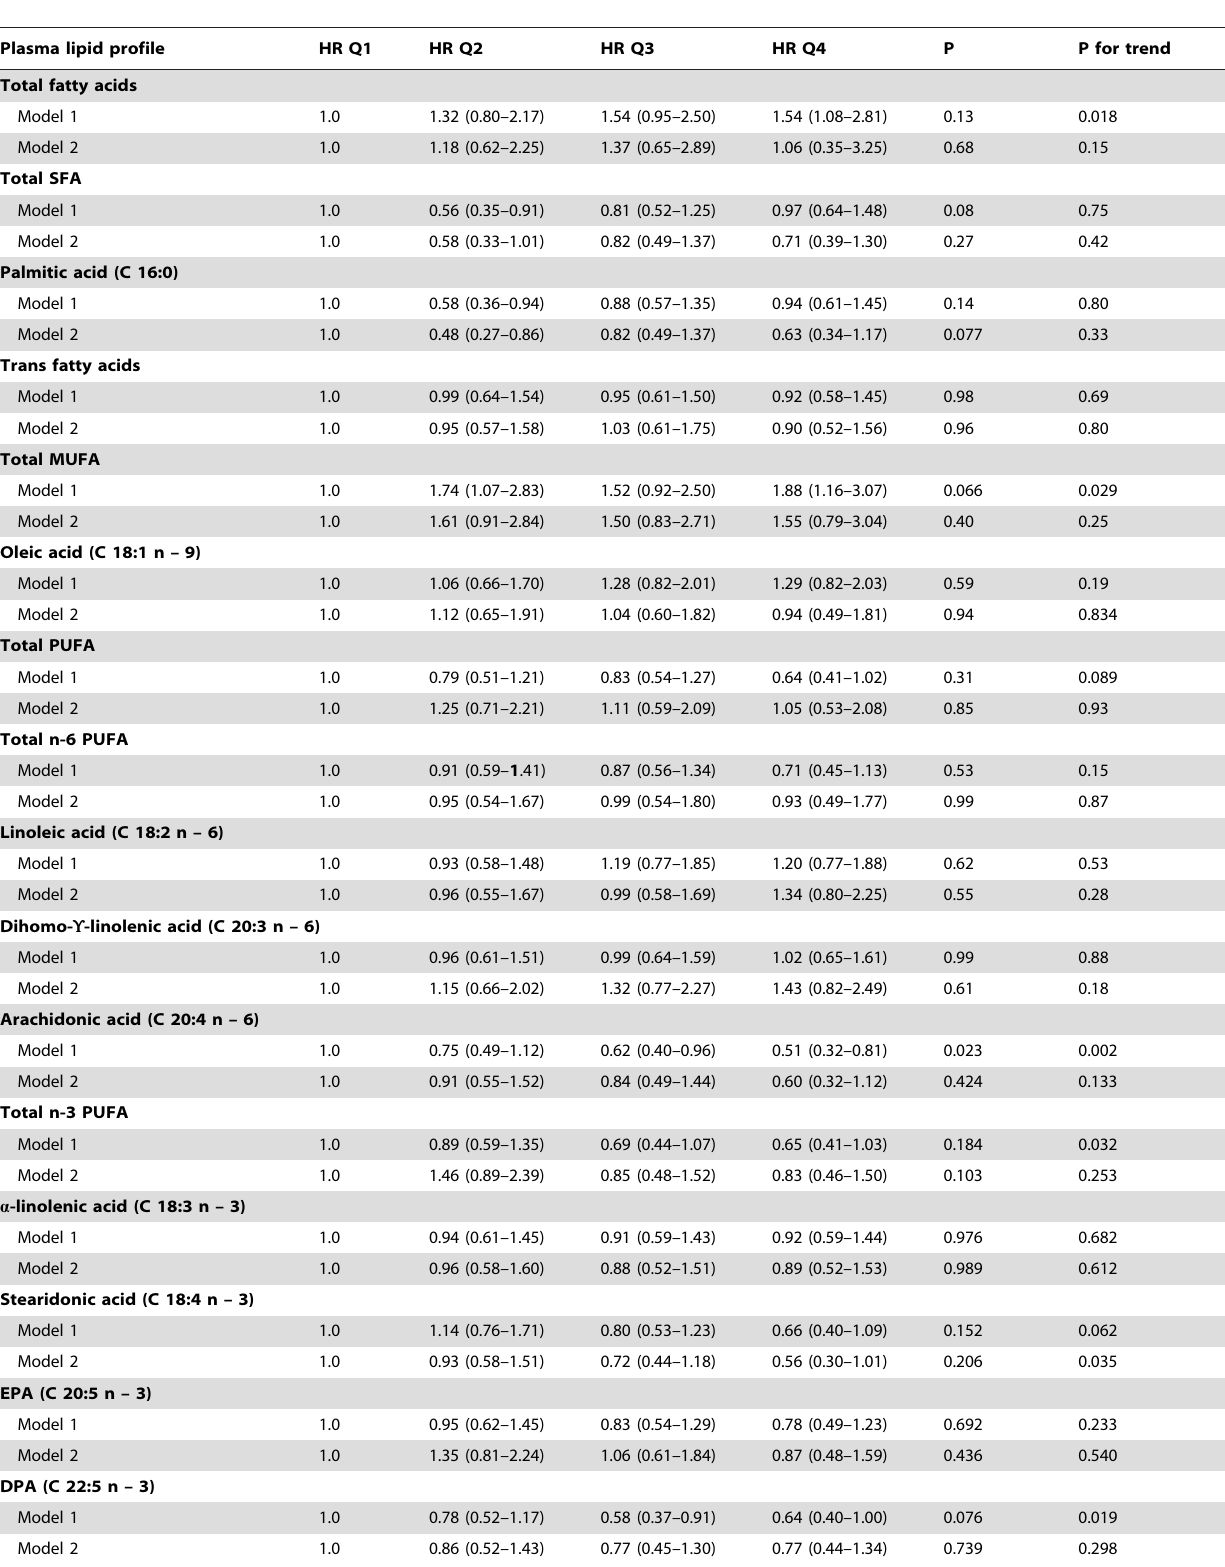
Table 3. Multivariate hazard ratios (95% confidence intervals) showing the associations between baseline plasma lipid profile and incident major events in the SU.FOL.OM3 study.